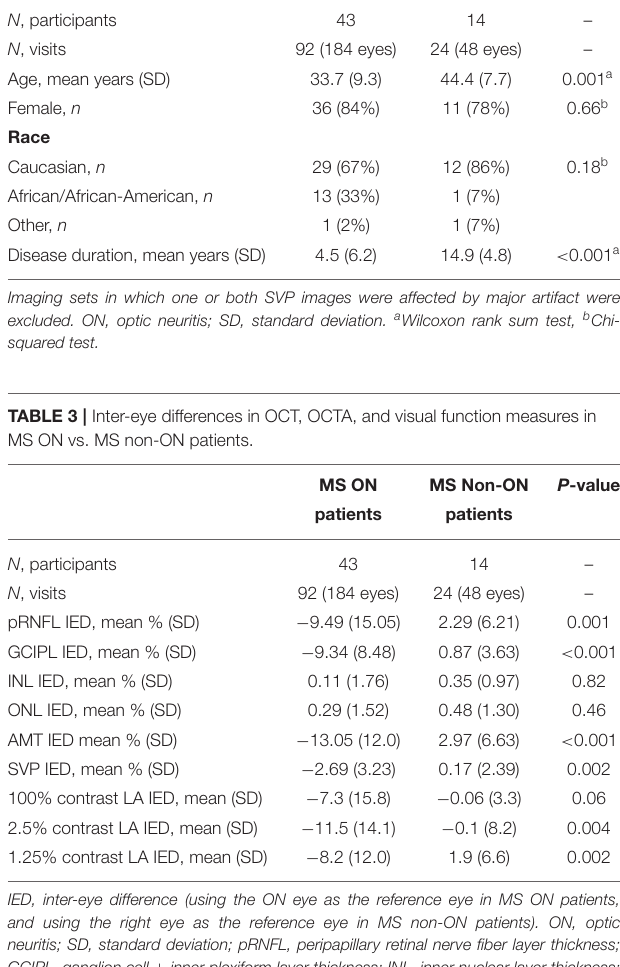
All patients ( n = 63)